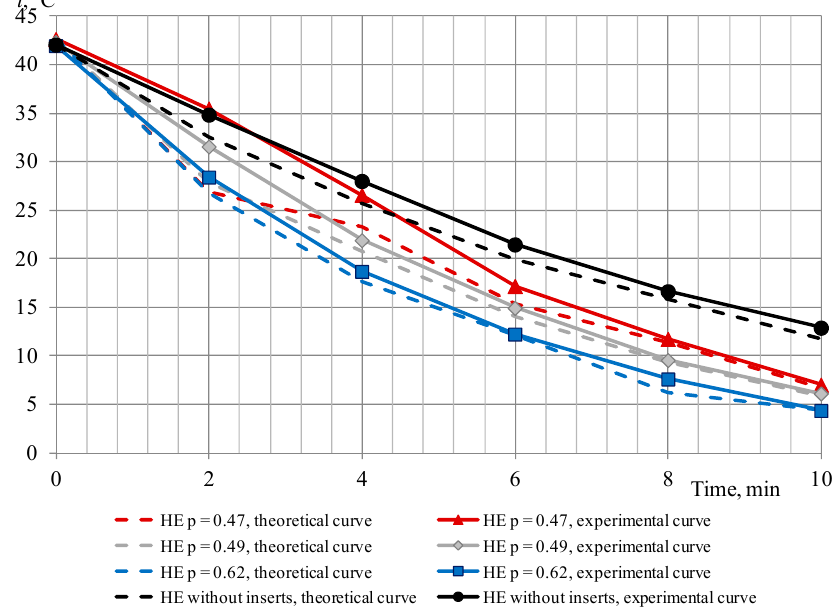
Figure 7. Calculated water temperature at the outlet of the heat exchanger and their comparison with experimental